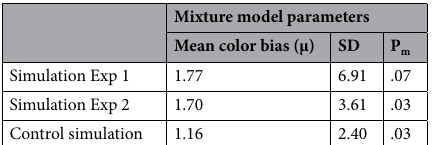
Table 1. Root mean squared errors between simulations and empirical